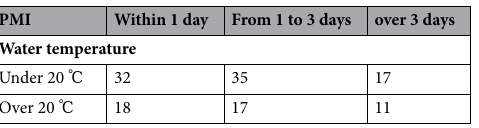
Table 3. The case number classified to PMI and water